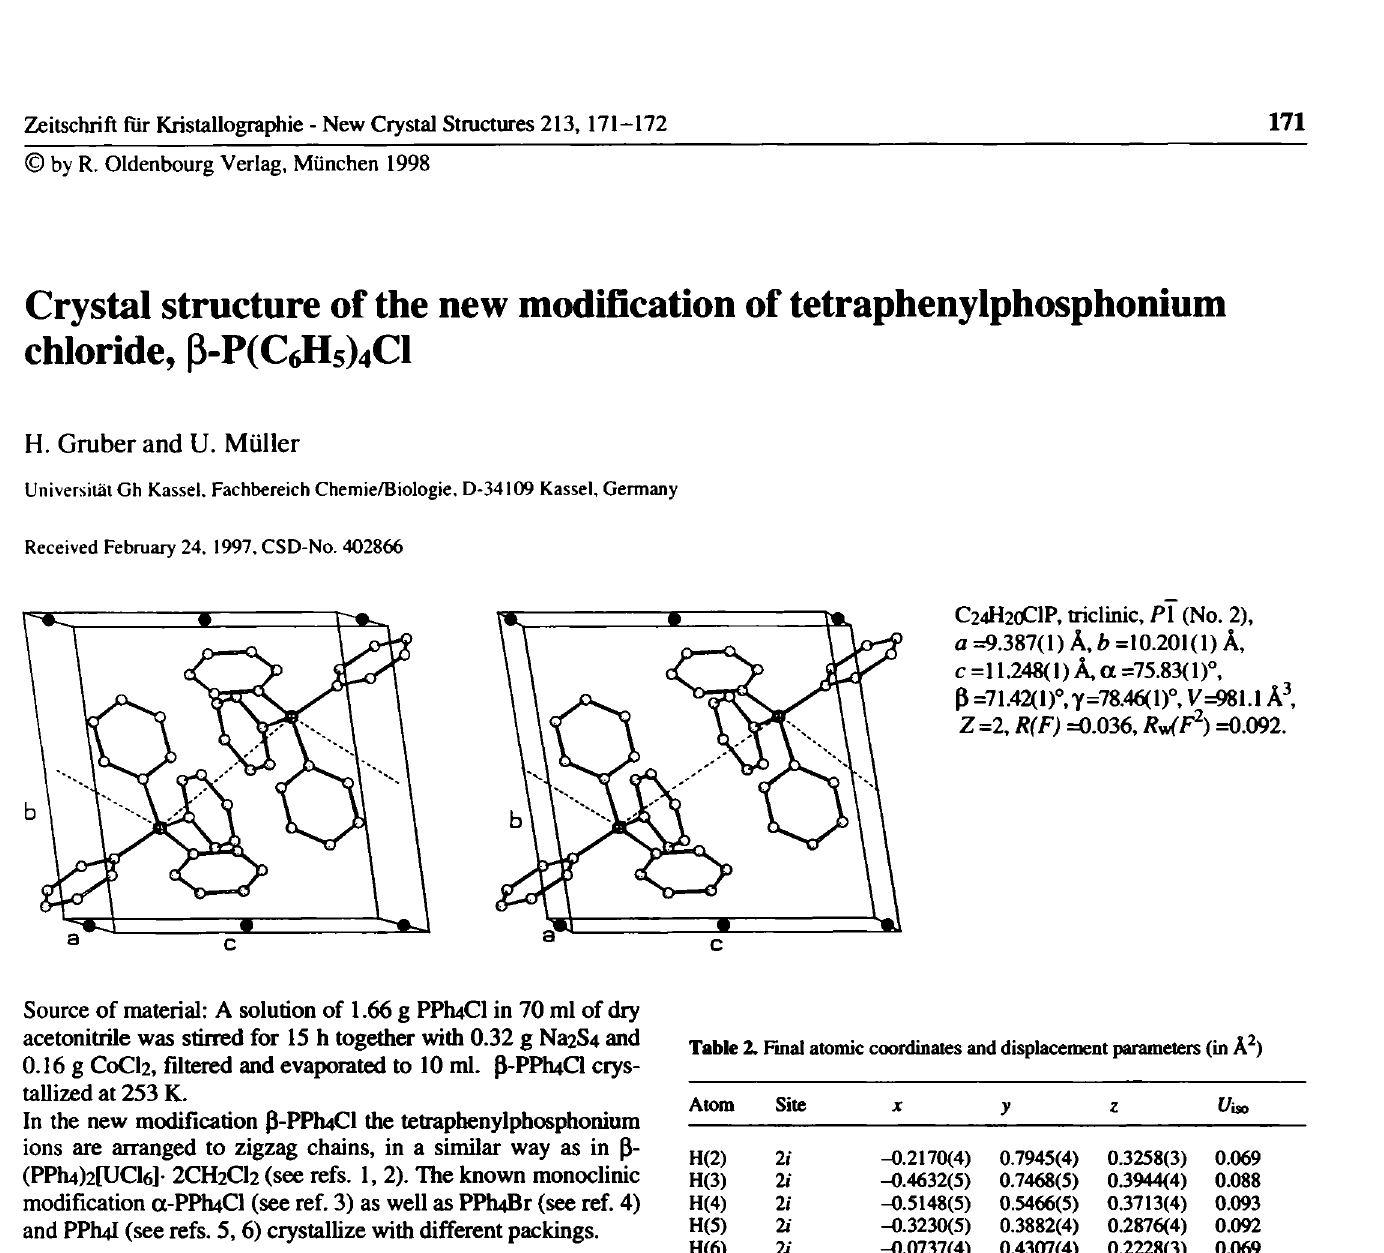
Table 1. Parameters used for the X-ray data collection